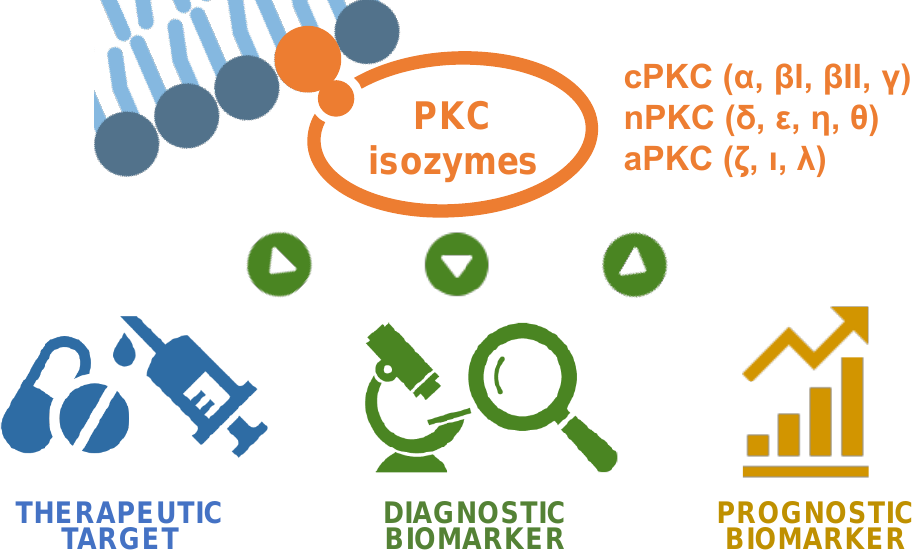
Figure 1. The PKC family consists of at least 11 isozymes that are classified into three subfamilies (cPKC, nPKC, and aPKC). The activation of PKC isozymes is positively associated with poor sur- vival rate, anticancer drug resistance, or increased recurrence in patients with cancer. Furthermore, higher levels of PKC isozymes are found in tissues or body fluids of patients with cancer compared to those in healthy individuals. These data suggest that PKC isozymes represent useful therapeutic targets and potential diagnostic and prognostic biomarkers for